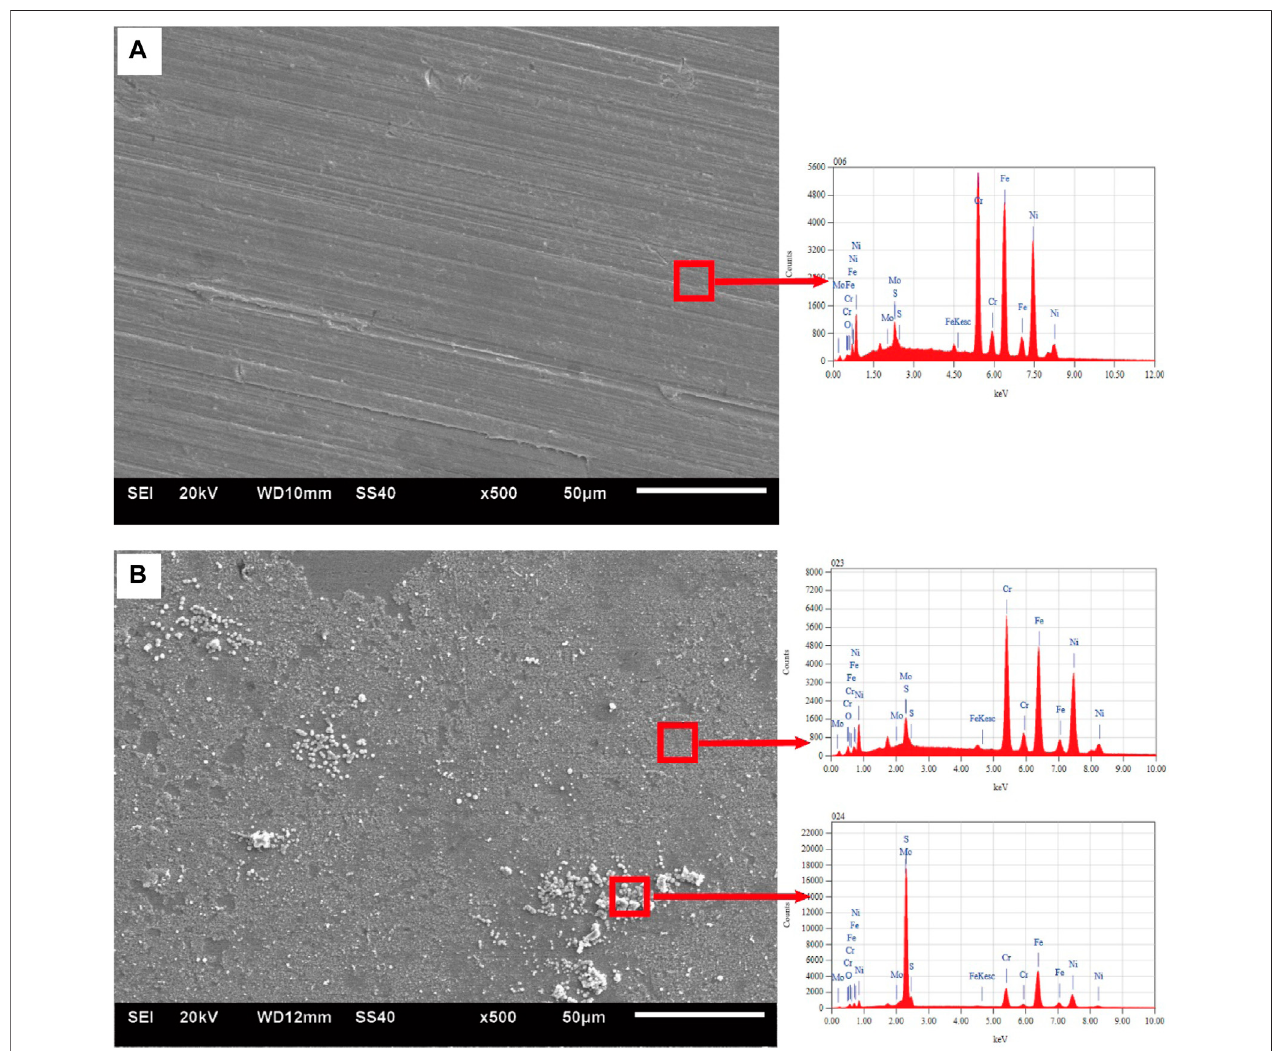
FIGURE 4 | SEM and EDS result of Alloy 825: (A) no obvious corrosion products at 150 ° C (B) particle corrosion products observed at 230 ° C.